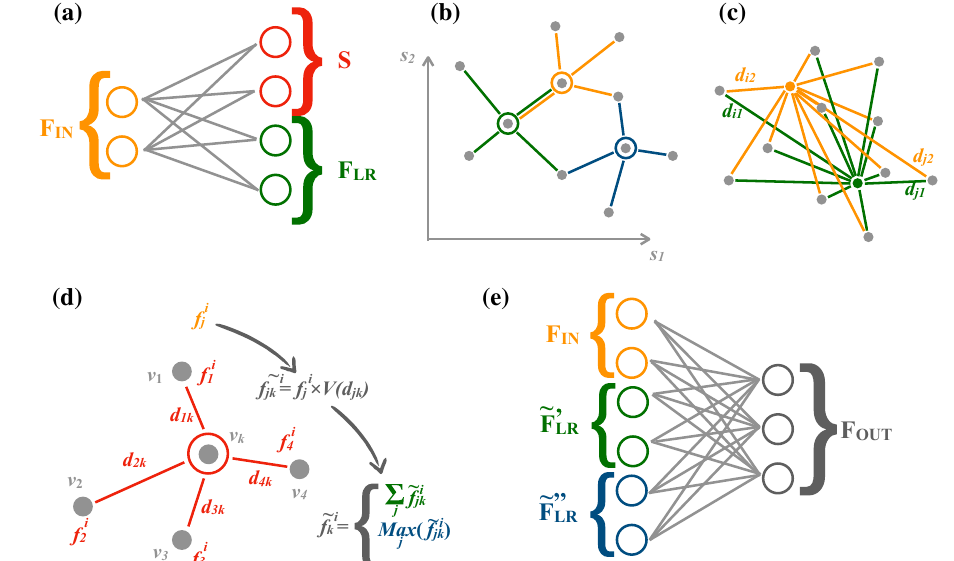
Fig. 1 Pictorial representation of the data flow across the GarNet and the GravNet layers. a The input features F IN of each v i ∈ V are pro- cessedbyadenseneuralnetworkwithtwooutputarrays:asetoflearned features F LR and spatial information S in some learned representation space. b In the case of the GravNet layer, the S quantities are inter- preted as the coordinates of the vertices in some abstract space. The graph is built in this space, connecting each v i to its N closest neigh- bors (N = 4 in the figure), using the euclidean distance d ij between the vertices to rank the neighbors. c In the case of the GarNet layer, the S quantities are interpreted as the distances between the vertices and a set of S aggregators in some abstract space. The graph is then built con-